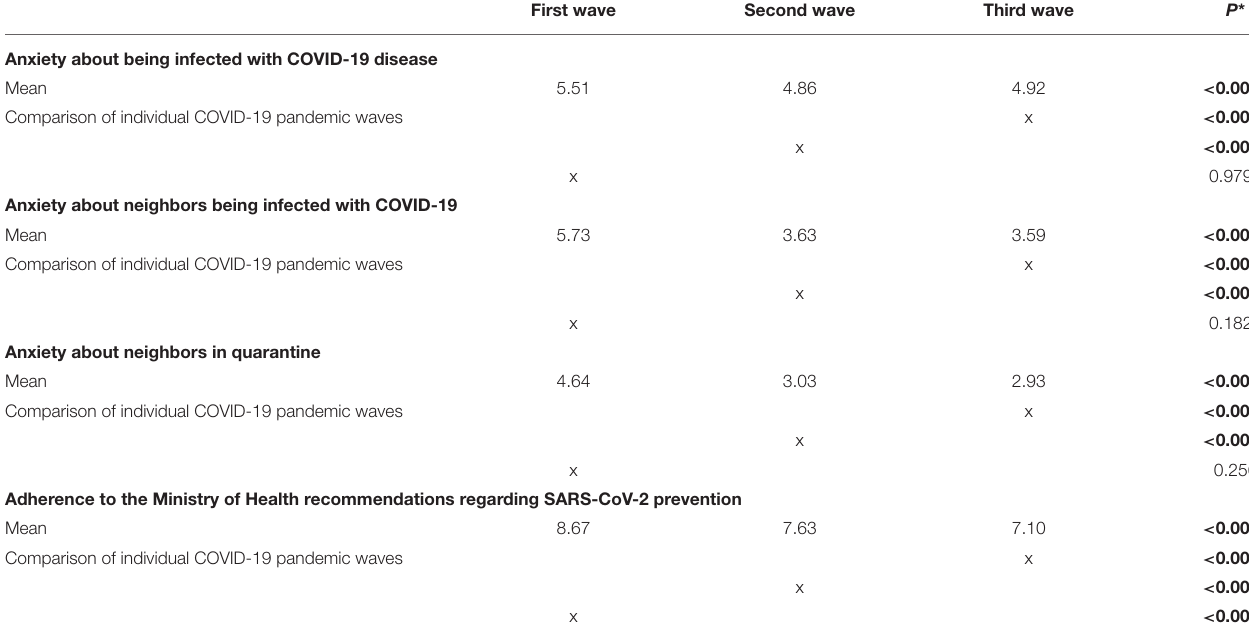
TABLE 6 | Comparison of mean scores of anxiety about being infected with SARS-CoV-2 and about neighbors in quarantine or neighbors being infected with COVID-19. First wave Second wave Third wave P